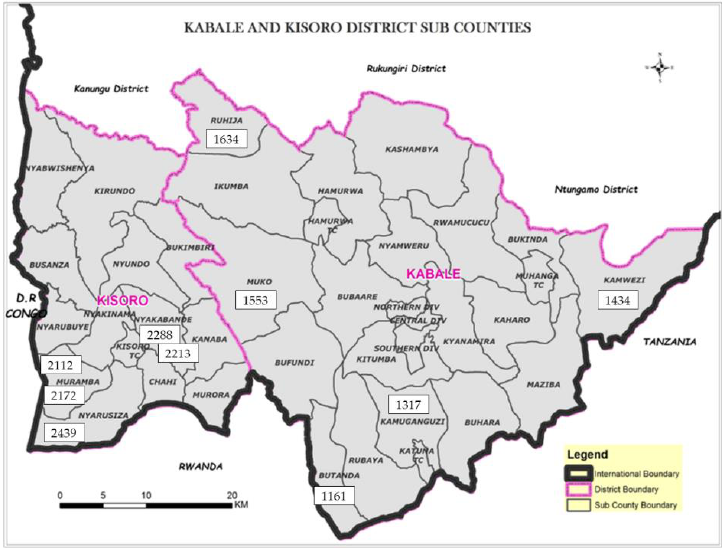
Figure 1. Map of Kabale and Kisoro showing subcounties where stool, urine, hulled maize, dehulled maize flour, and peanuts were sampled in this study. The geographic locations of the ten children (aged 54 to 60 months) are indicated by child identification